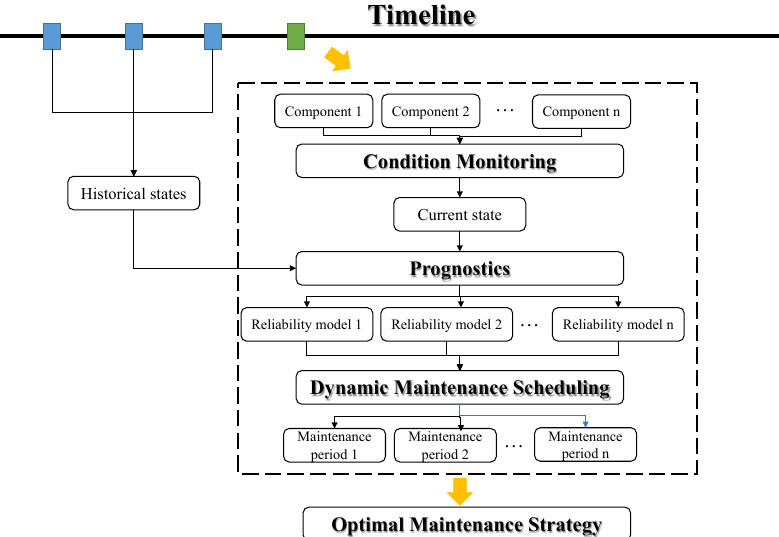
Figure 3. The workflow of dynamic maintenance